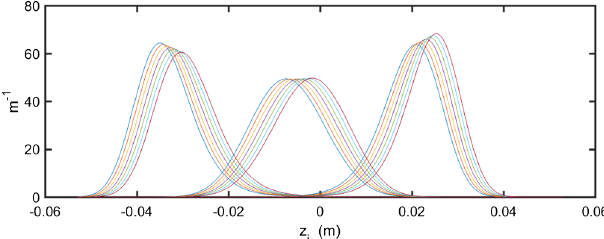
gaps.FIG. 5. Results for a single gap of 44 empty buckets. On the right, seven bunches within the first 24; in the middle, seven bunches within the middle 24; on the left, seven bunches within the last